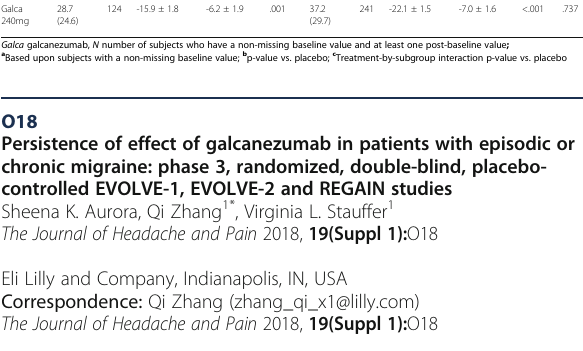
≥ 2 prior preventive treatments or preventive treatment classes. Subgroup-by-treatment interactions were calculated using linear or generalised linear mixed models. Results